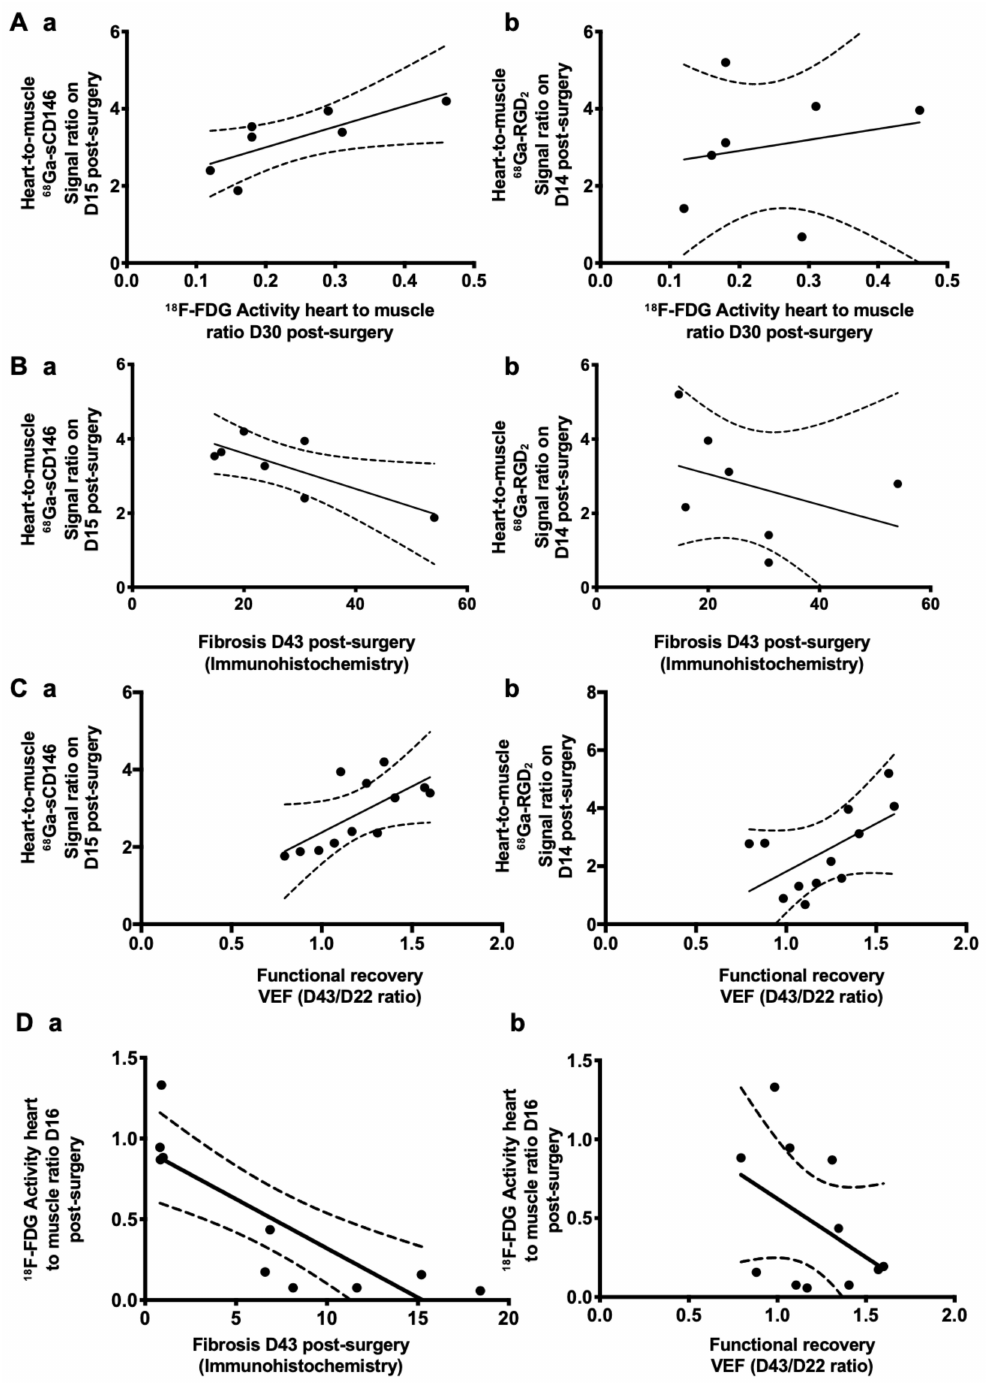
Figure 5. Correlation analysis. ( Aa ) Significant positive correlation between residual perfusion recovery perfusion recovery evaluated by 18 F-FDG microPET signal expressed as heart-to-muscle ratio on day 30 and 68 Ga-sCD146 microPET signal intensity expressed as heart-to-muscle ratio on day 15 post-myocardial infarction (Pearson R 2 = 0.70; p = 0.04; n = 7). ( Ab ) No significant correlation was observed between individual residual perfusion recovery and 68 Ga-RGD 2 microPET signal intensity on day 14 post-ischemia (Pearson R 2 = 0.21; p = 0.64; n = 7). ( Ba ): Significant negative correlation was detected between individual fibrosis quantification evaluated by histological Sirius red staining